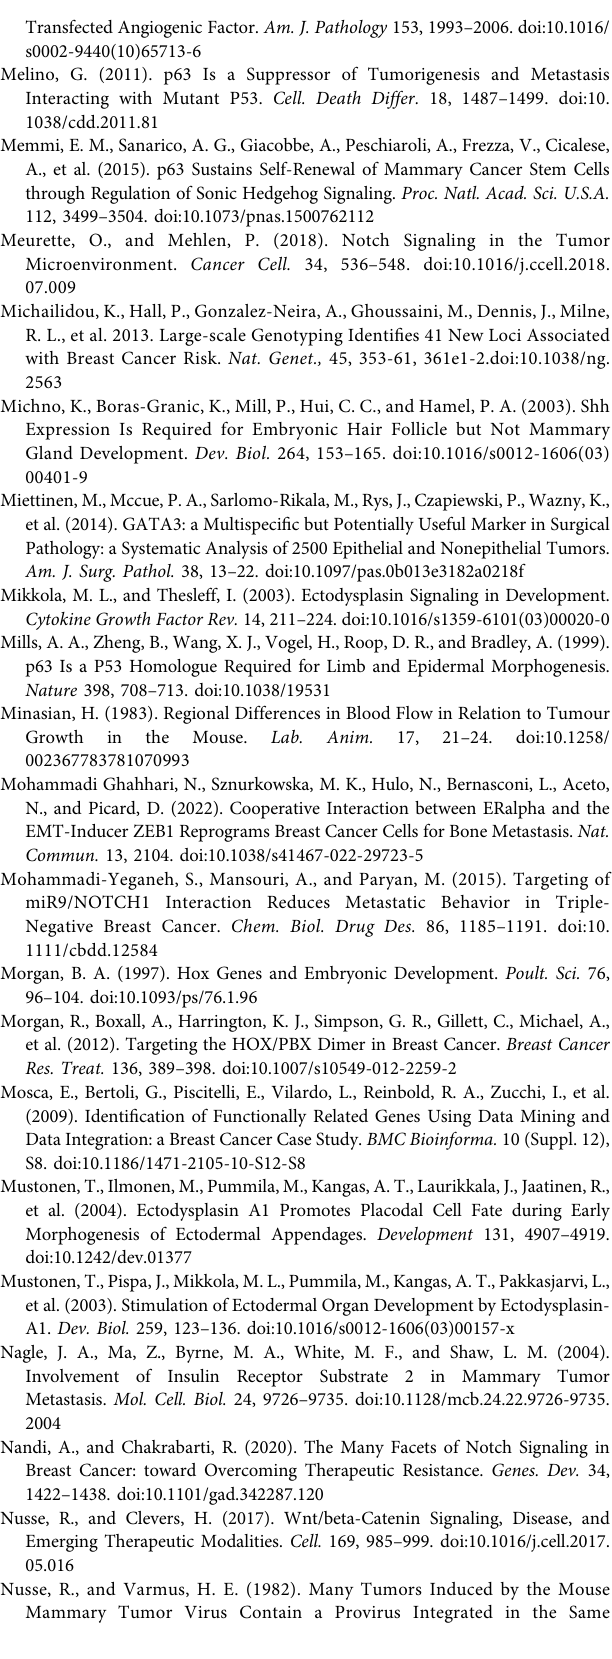
Frontiers in Cell and Developmental Biology |